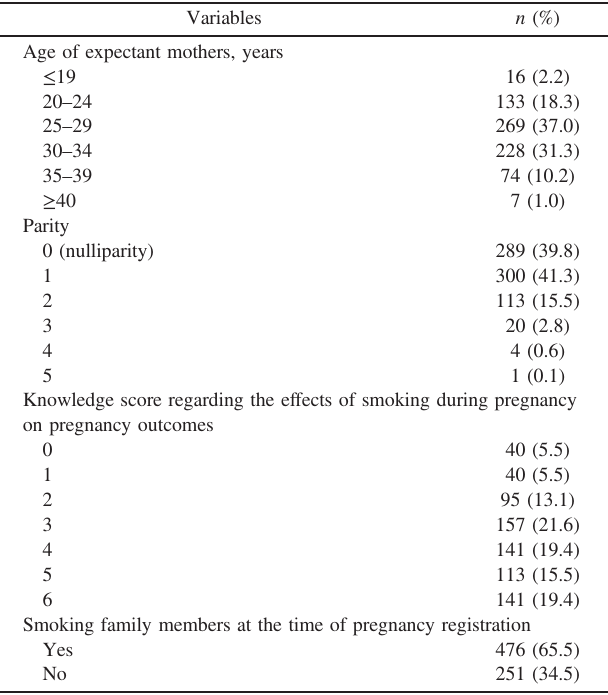
Table 1. Characteristics of study participants at pregnancy registration ( n = 727) Variables n (%) Age of expectant mothers, years ≤ 19